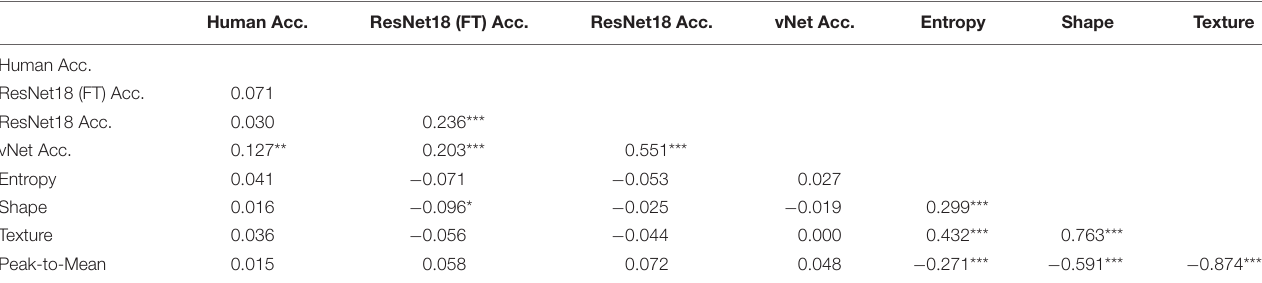
TABLE 1 | Spearman rank correlation between human observer accuracy, DCNN accuracy, and image properties. Human Acc. ResNet18 (FT)